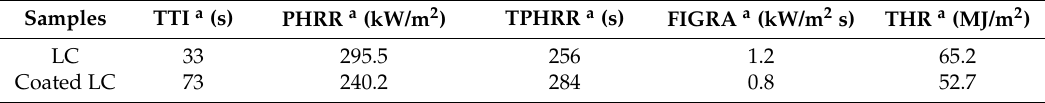
Figure 9. Cone calorimeter parameters of LC and LC coated with PDMS@STA-KL: ( a ) heat release rate; ( b ) total heat release. Table 1. Cone calorimeter data of LC and LC coated with